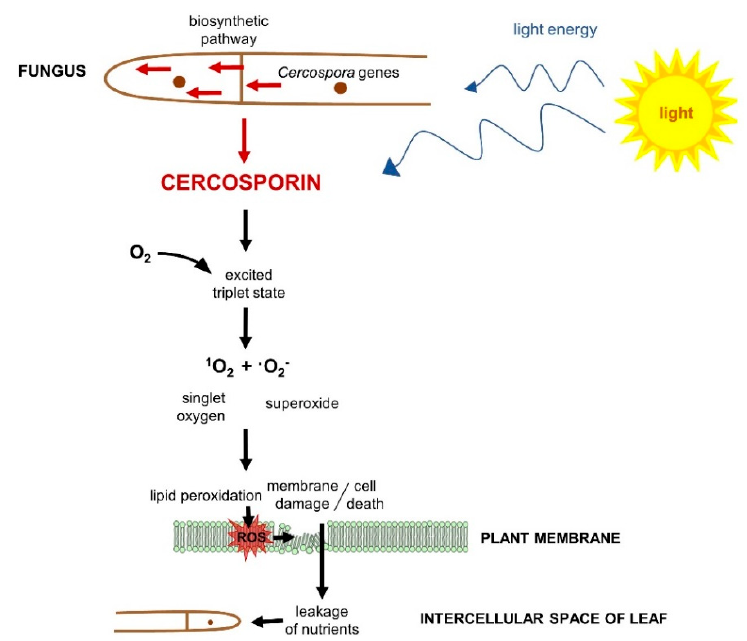
Figure 2. The scheme of cercosporin action (adopted from Daub and Ehrenshaft [54], Daub and Chung [59], and Fuller et al. [60]).